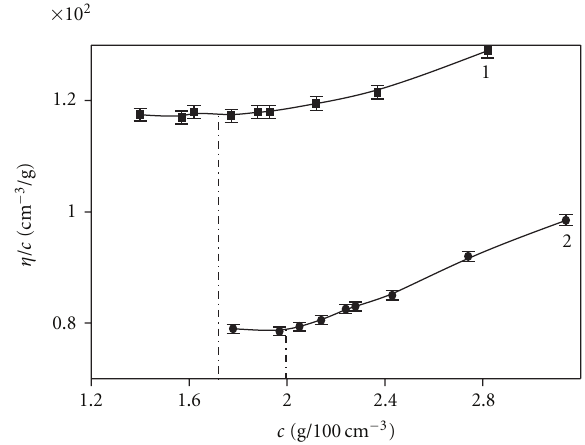
Figure 4: The plot of the reduced specific viscosity versus Na-CAS content in water (1) and 0.2 M NaCl solution